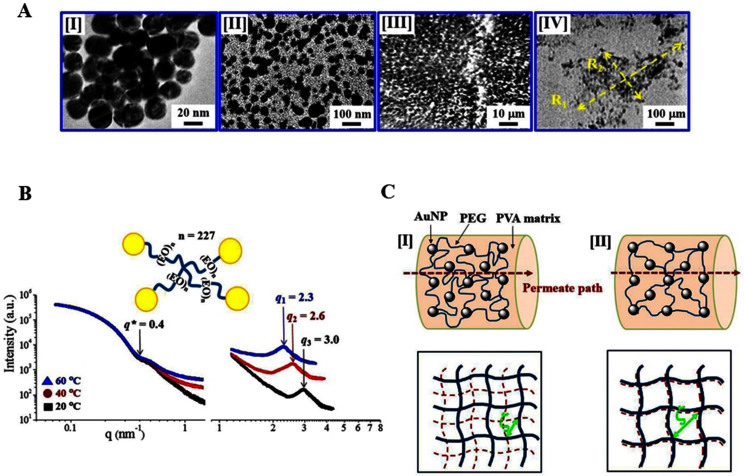
(a) [I] TEM image of gold nanoparticle (AuNP) use for linterlinking. Binary functional polyethylene oxide (PEO) having EO unit number of n = 227 (2PEG 10000) is used for linking AuNPs. Representative images of the designed nanocomposites. [II] TEM, [III] X-ray nanoscopy (XN) and [IV] X-ray microscopy (XM). (b) Small angle X-ray scattering (SAXS) results of the designed AuNP-PEG nanocomposite in solution state in broad q ranges (two Sample-to-detector distance conditions are combined). A critical q value (marked by q*) exist from which temperature-responsiveness is diversified, indicating dual regions of the designed network: stable large-scale domain at low q and responsive small-scale domain at high q. Characteristic size is determined according to the temperature detected by q1 (60°C), q2 (40°C) and q3 (20°C). (c) Illustration of responsive network structures. Pore size variation of the nanocomposites in PVA matrix induced by the stimuli-responsive PEOs through which permeates are transported. [I] Swollen PEOs generates (or block) small path for permeate molecules. [II] Shrunken PEOs allow relatively wide pathway for effective permeate transport. The correlation lengths (ζ) are determined based on the pictures below. Bold lines denote stable connection, whereas dotted lines indicates flexibly responsive chains by the external stimuli.